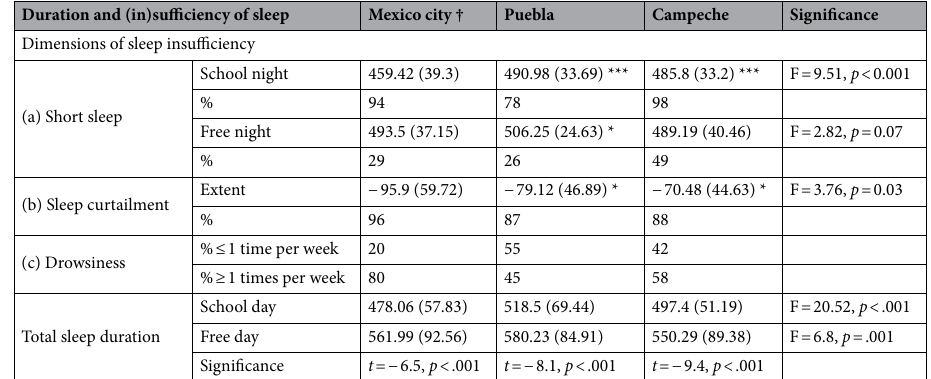
Table 4. Comparison of total sleep duration (TSD) and dimensions of sleep insufficiency between post- industrial urban (Mexico City), and rural agricultural Totonac (Puebla) and Maya (Campeche) adolescent populations. Data are represented in minutes as mean (standard deviation). (a) Prevalence and comparison of short sleep quotas (< 9 h/night) on school nights and free nights among the three study sites. (b) Prevalence, extent, and comparison of sleep curtailment values (calculated through the subtraction of the TSD on school days from the TSD on free days). Sleep curtailment can be expressed as a negative value when TSD is shorter during school days compared to free nights, a 0 value when equal, and a positive value when greater. c) Self- rated prevalence of daytime drowsiness on school days over a 1-month time interval. ‘† ‘ reference group.